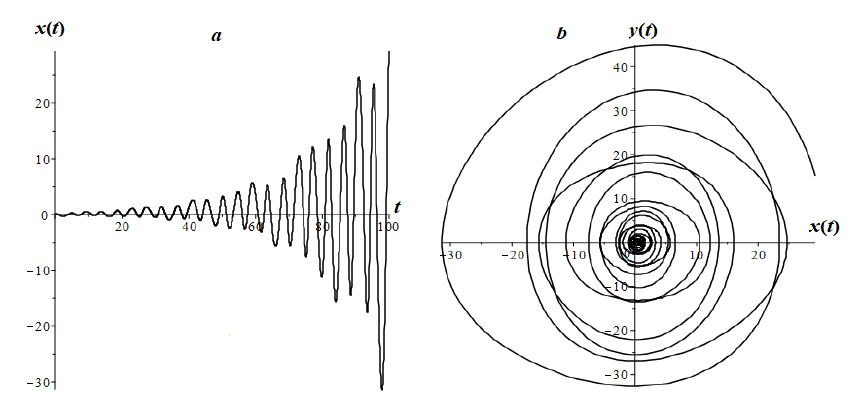
Figure 16. Ordinary Mathieu oscillator without friction in free oscillation mode: ( a ) oscillogram; ( b ) phase trajectory.